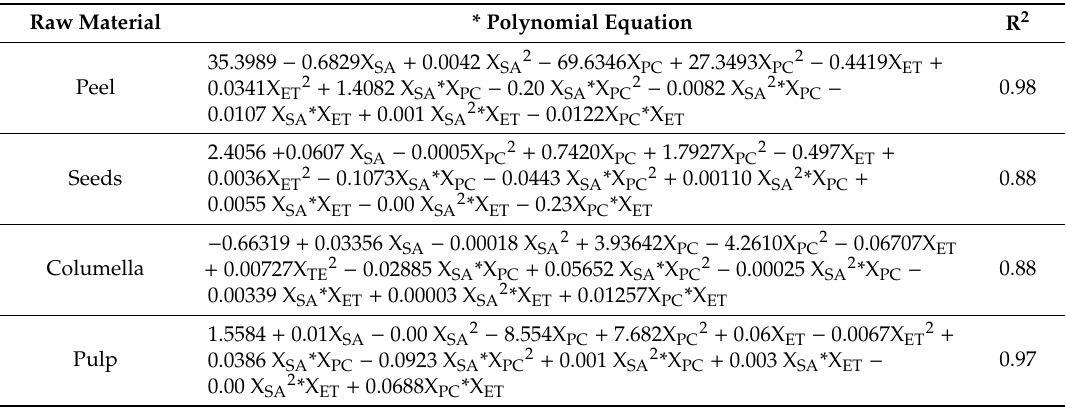
Table 2. Predicted mathematical model for the extraction of total alkaloids (mg / g DW) from the peel, seed, columella, and pulp from Annona muricata after the UAE.